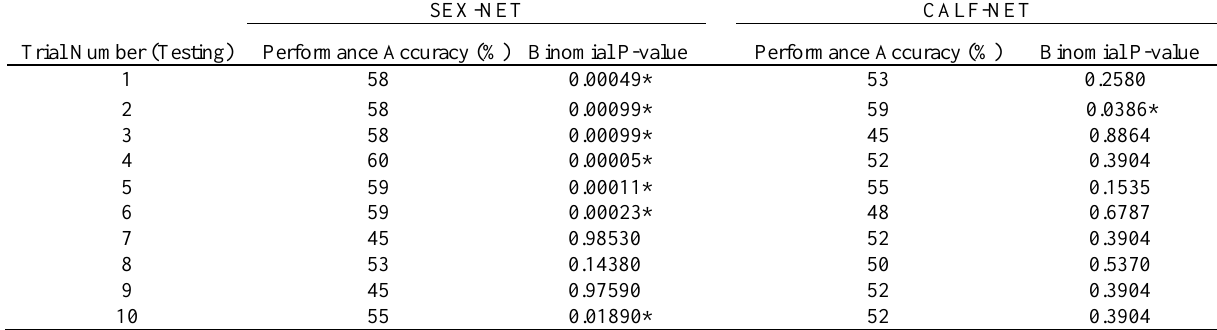
Binomial test p-values calculated for the performance accuracy of each network during generalization testing with novel inputs